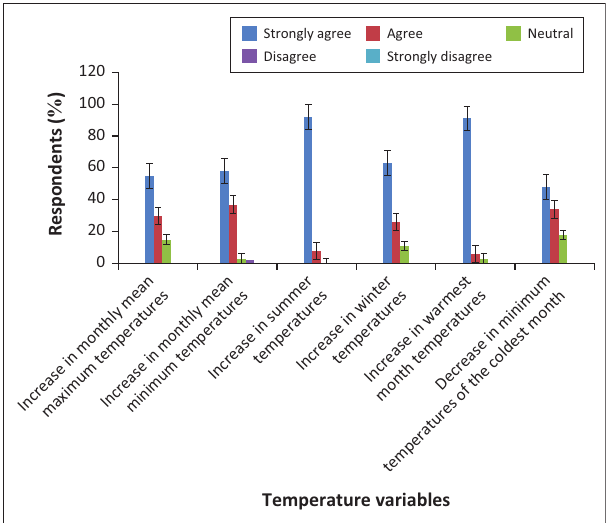
FIGURE 4: Perceptions of temperature changes in Masvingo city, Zimbabwe ( n =